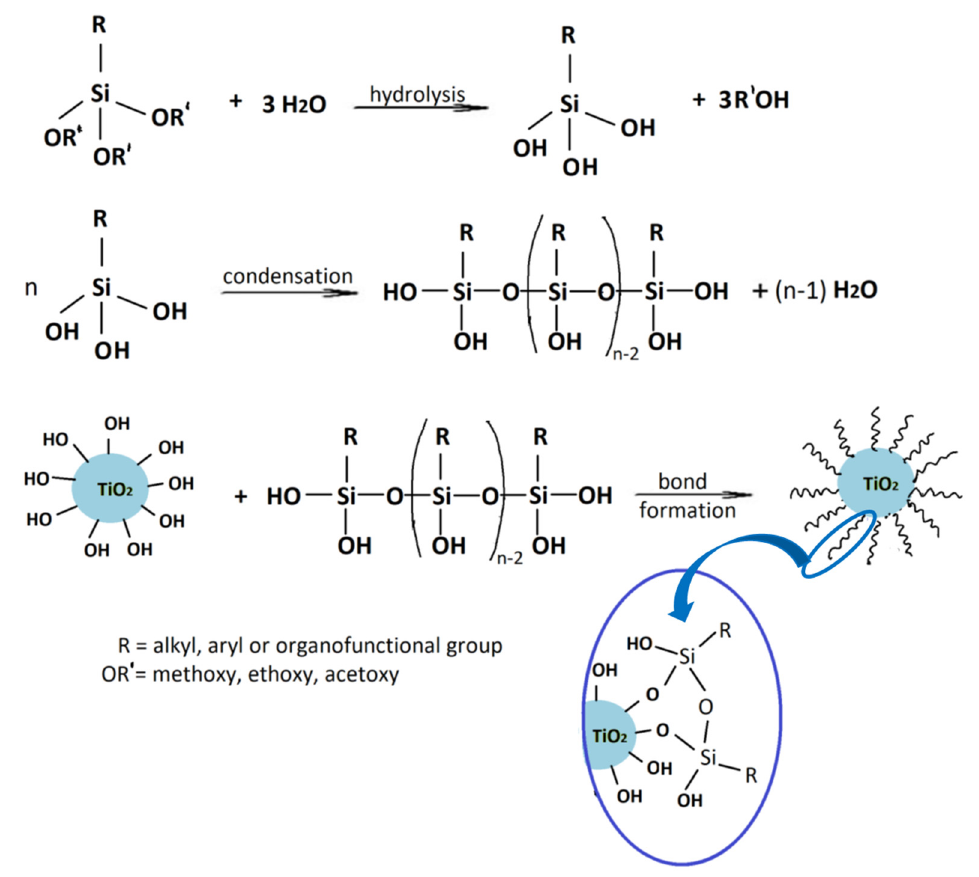
Figure 3. The interaction between the coupling agent molecule and the filler.